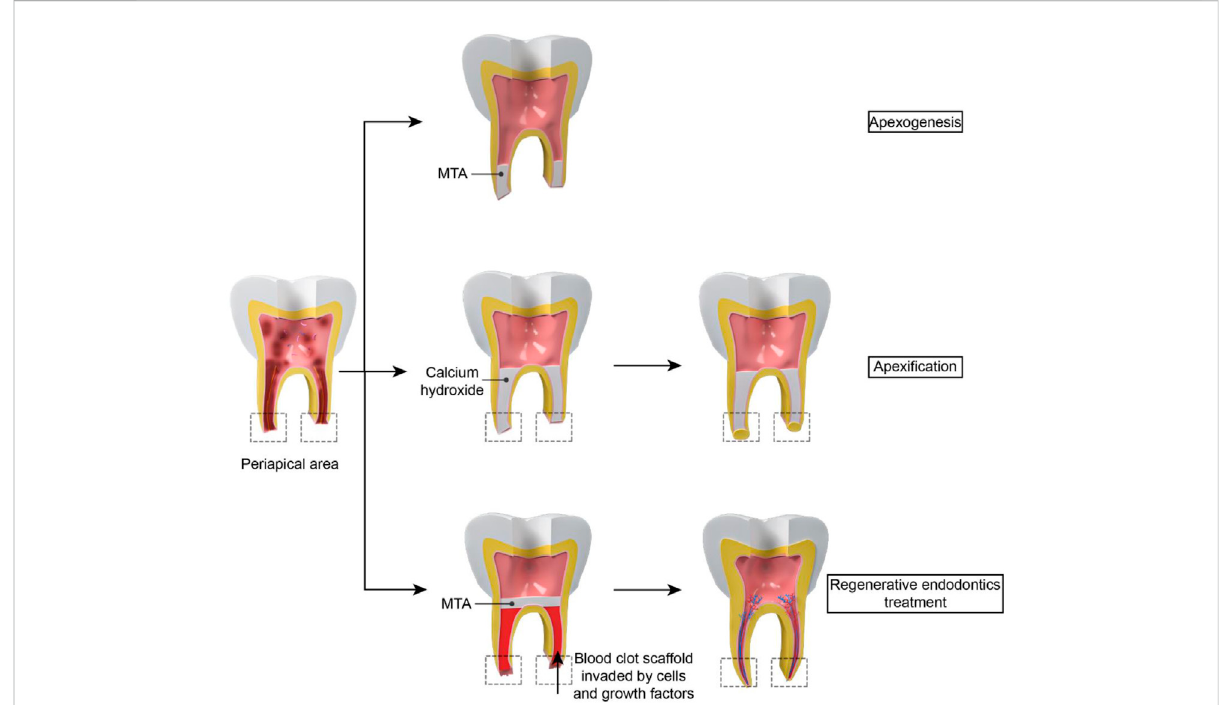
FIGURE 1 The difference between apexogenesis, apexi fi cation and RET: For apexogenesis, MTA is placed in the apical 1/3 of the root canal to form an unnatural barrier. For apexi fi cation, biomaterials such as calcium hydroxide is put in the root to stimulate the creation of a mineralized barrier in the root apex. However, vessels cannot regenerate in the pulp cavity. For RET, periapical tissue tearing results in a blood clot which acts as a natural scaffold for stem cells and growth factor to grow into. Then the closure of the apical foramen and/or the thickening of the root canal walls can be observed in the